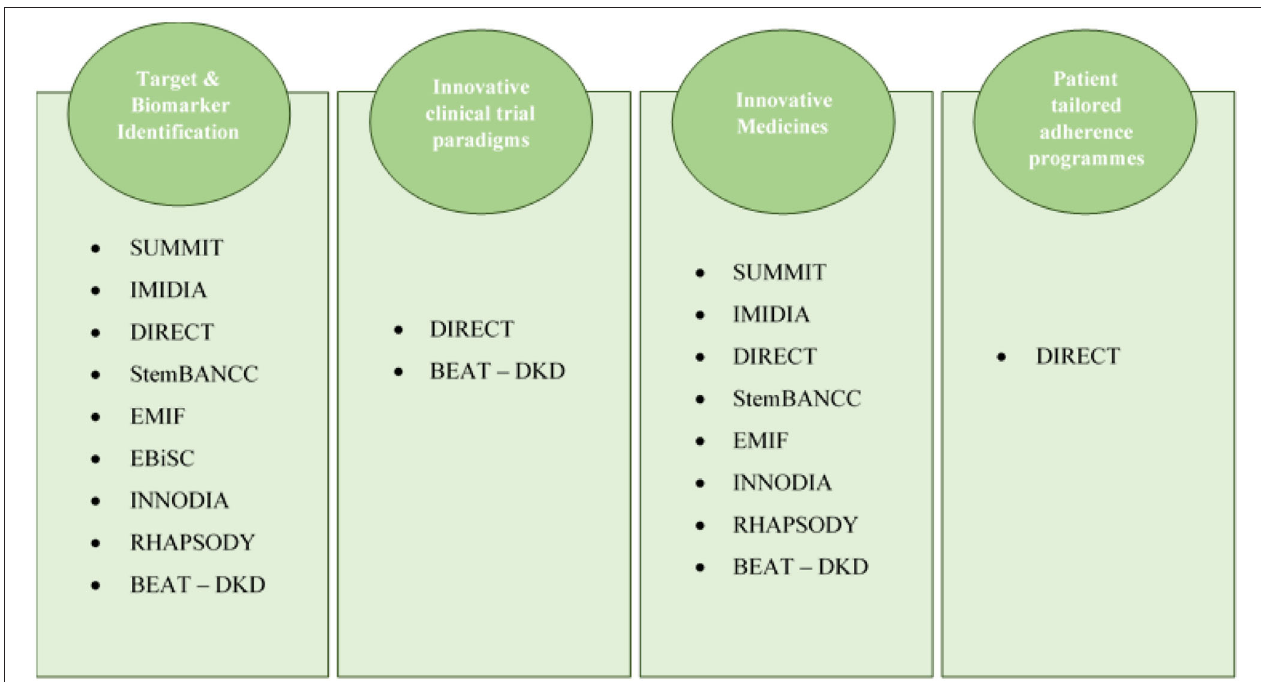
FIGURE 2 | Projects’ distribution according to their outcomes and the axes of the IMI2 programme.